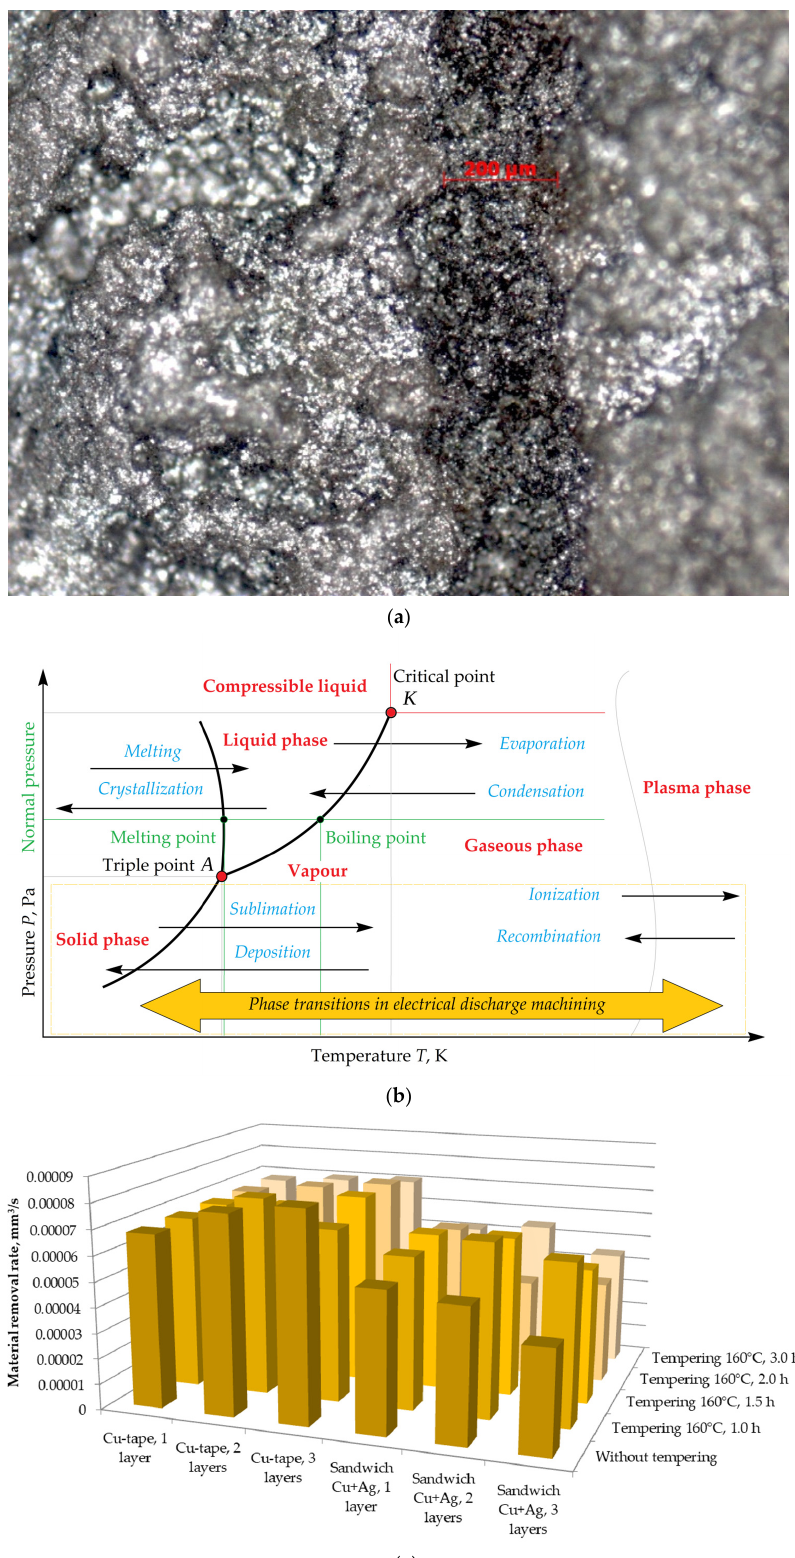
Figure 4. ( a ) The preliminary testing results of the electrical discharge machining of samples coated with a silver adhesive (optical microscopy), 10×; ( b ) phase transitions and states of oxide ceramics; ( c ) the preliminary testing results of the electrical discharge machining of alumina using Cu-Ag and Cu mono- and multi-layer coatings and various coating tempering modes.